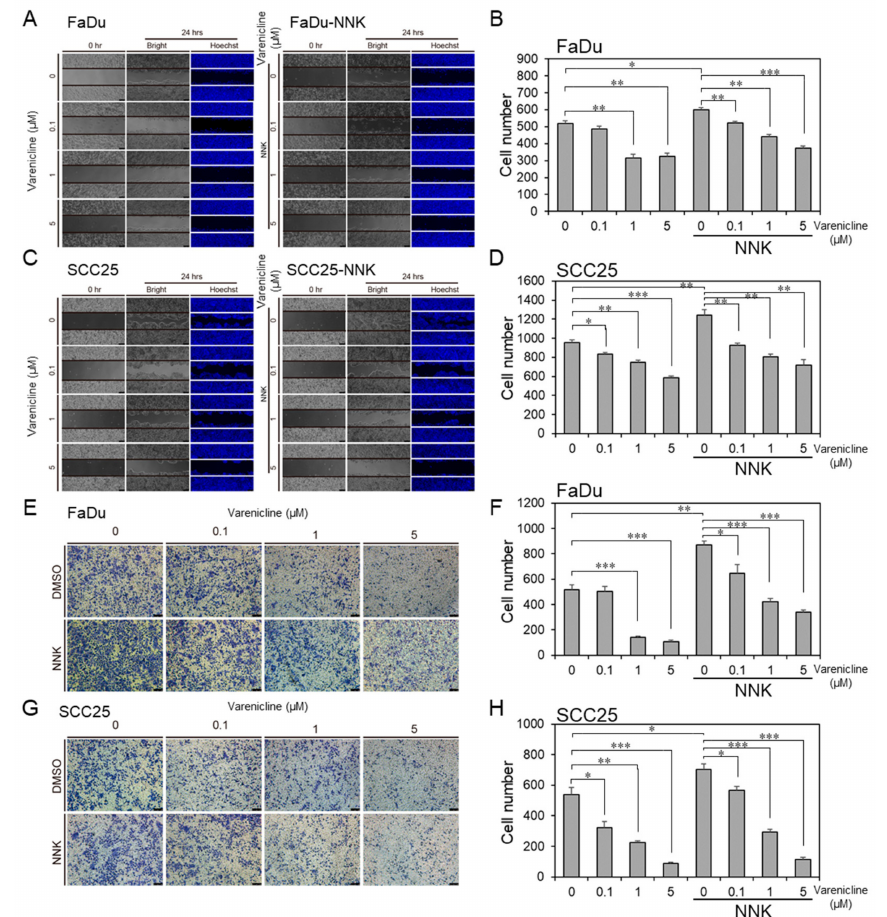
Figure 8. An FDA-approved drug, varenicline, inhibits migration and invasion in NNK-treated cells. Migration ability was measured after 24 h of varenicline treatment at 0.1, 1, and 5 µ M in ( A , B ) FaDu and ( C , D ) SCC25 cell lines with or without NNK treatments. Invasion ability was measured after 48 h of varenicline treatment at 0.1, 1, and 5 µ M in ( E , F ) FaDu and ( G , H ) SCC25 cell lines with or without NNK treatments. The experiments were repeated three times, and a two-sided p -value was calculated with Student’s t -test. The error bars indicate the standard error. p -values less than 0.05, 0.01, and 0.001 are denoted by *, **, and ***,